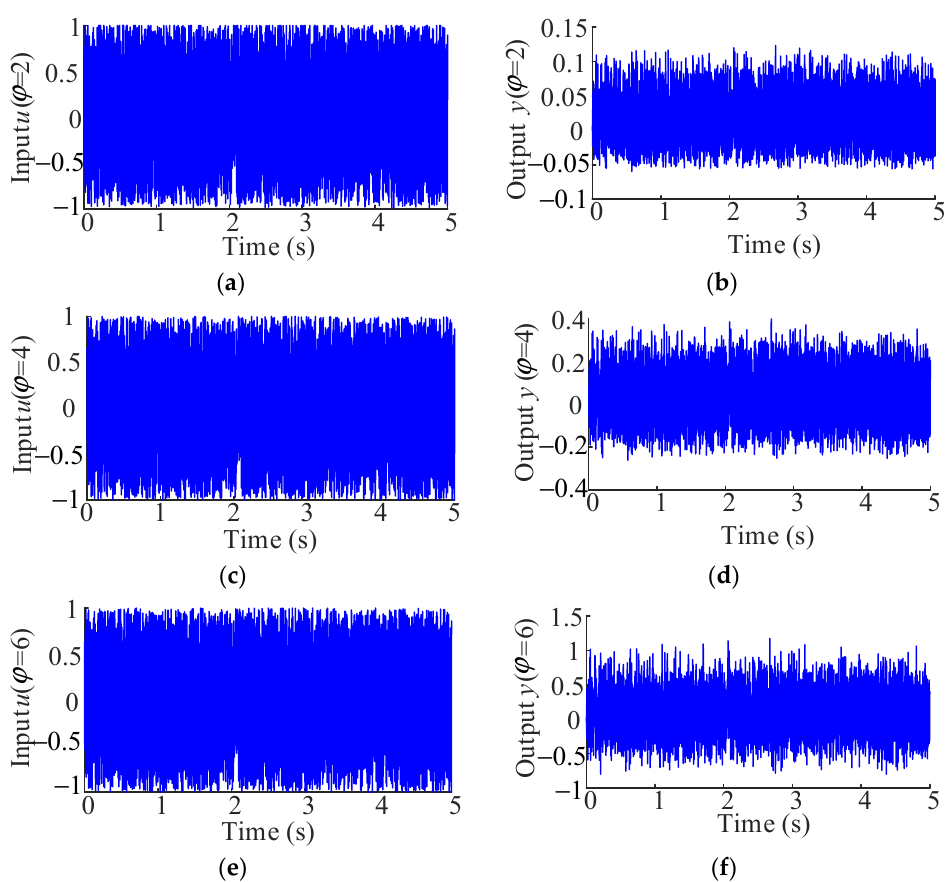
Figure 1. Input and output signals of φ = [2,4,6]. ( a ) Input signal of φ = 2; ( b ) output signal of φ = 2; ( c ) input signal of φ = 4; ( d ) output signal of φ = 4; ( e ) input signal of φ = 6; ( f ) output signal of φ = 6. Table 1. The CMS identified by using the traditional EFOR